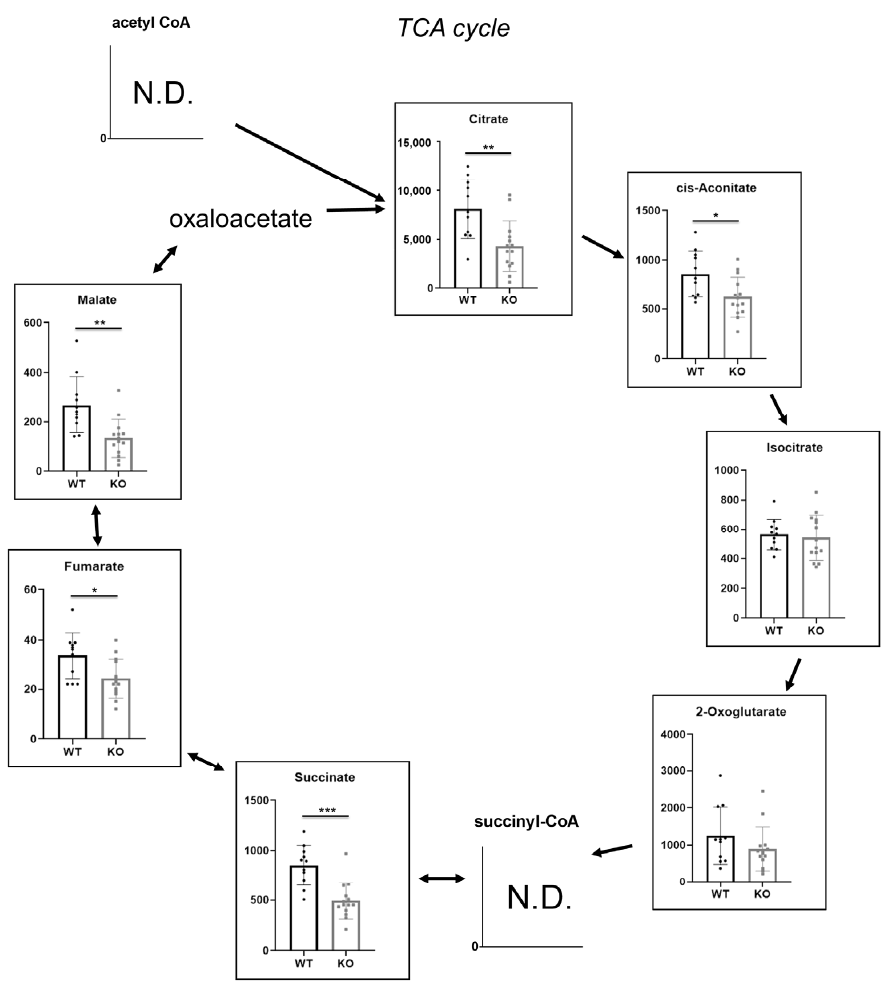
Figure 4. Metabolome analysis of urine from ten-week-old Hao1 KO and wild-type mice. Data Figure 4 represent mean values of indicated parameters ± S.D. (* p < 0.05; ** p < 0.01; *** p <